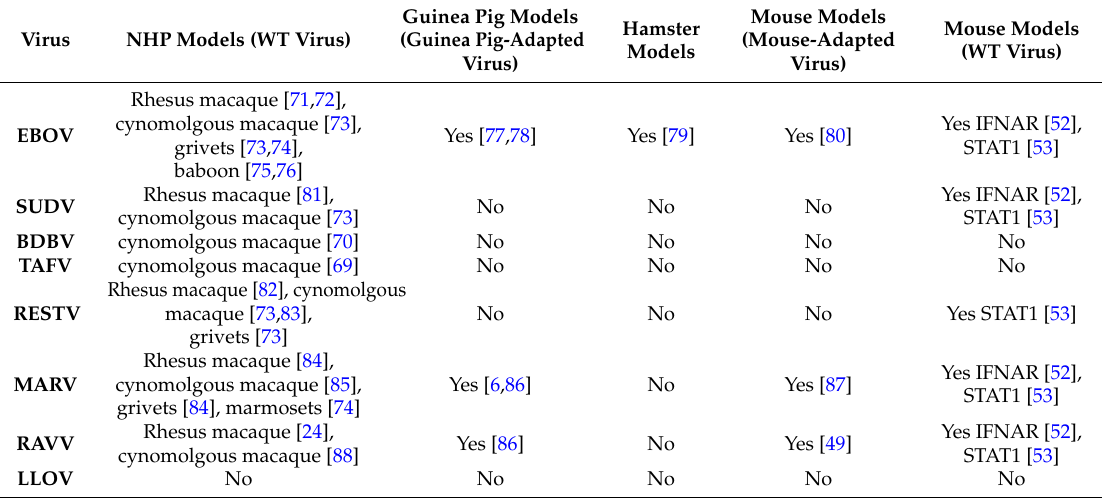
Table 4. Animal models for filovirus